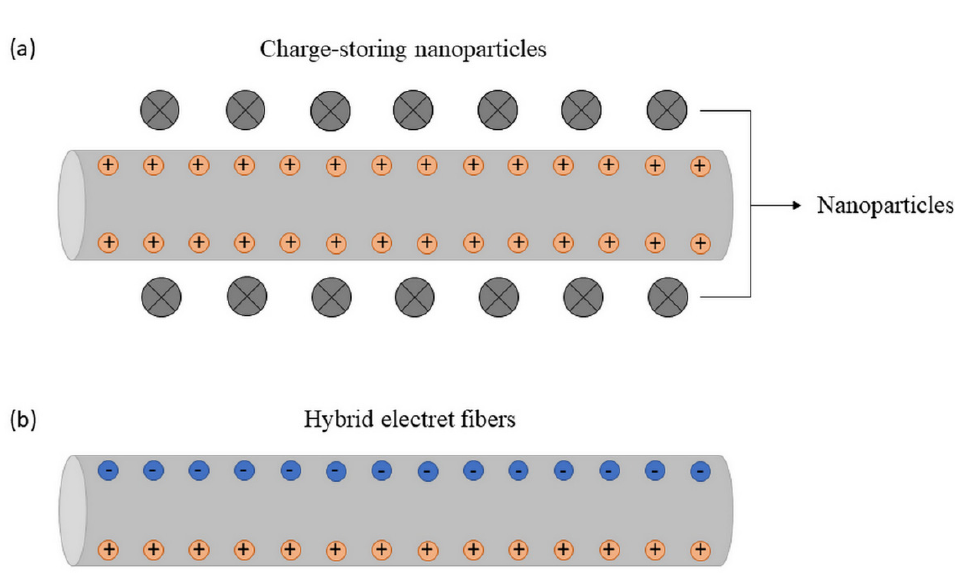
Figure 6. Electret fibers: ( a ) nanoparticles as an enhancer for charge storage; ( b ) fully polymeric hybrid.